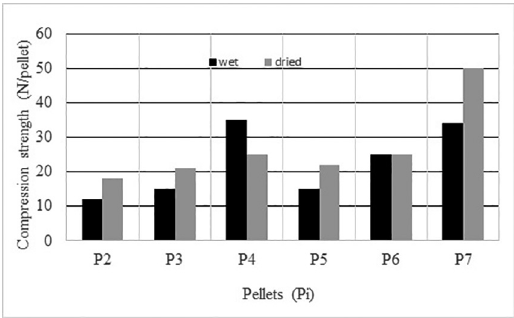
Figure 2: Compression strength of pellets under wet and dried